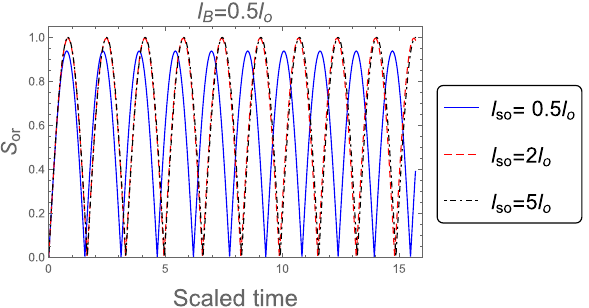
l so 0.5 l o , 2 l o , and 5 l o when the robust : =